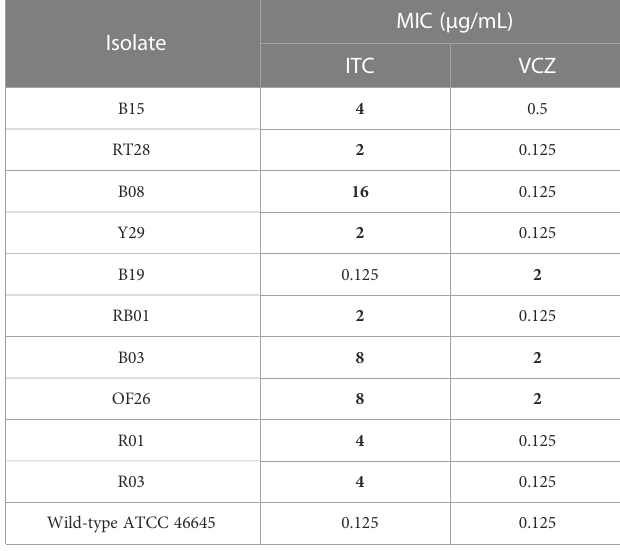
*Bold letters depicted MIC above ECV values i.e.,>1 µg/mL for itraconazole (ITC) and voriconazole (VCZ).